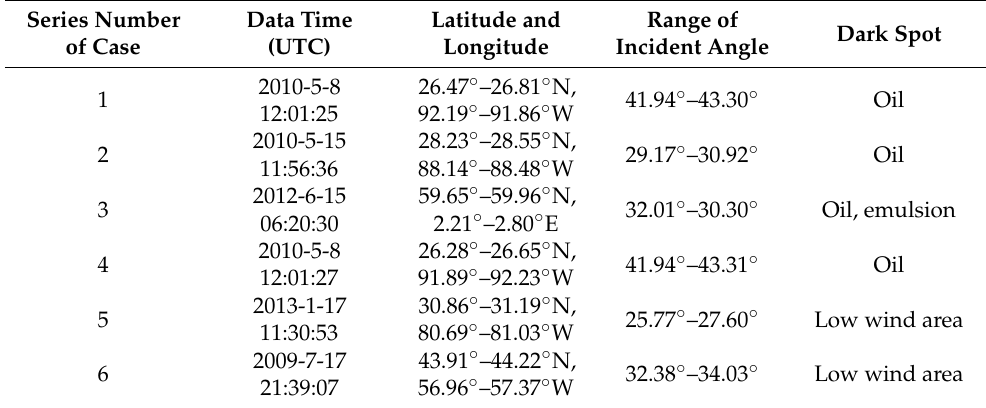
Table 1. SAR data acquisition information, indicated by series number. Slicks of emulsion refer to mixtures of crude oil and seawater [25].